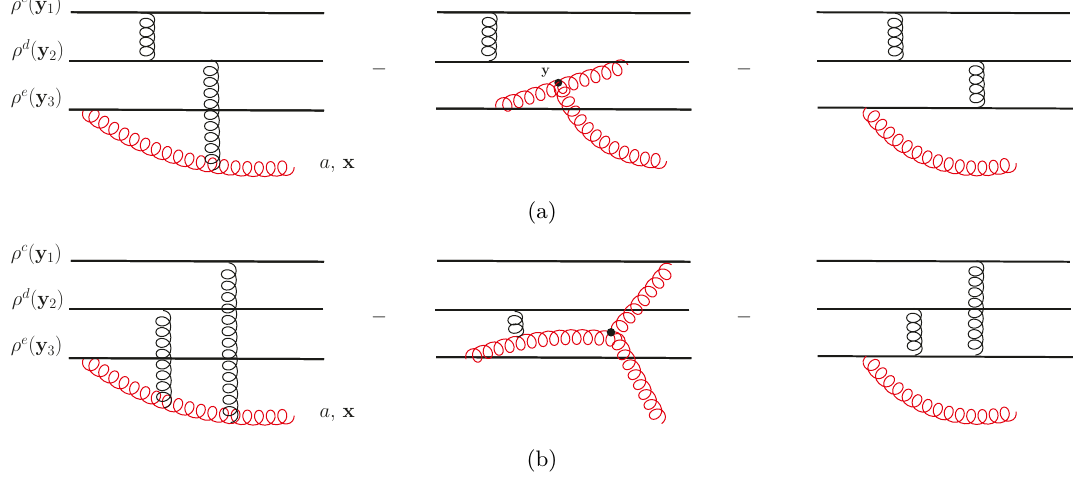
( x ) produced at transverse P , y and y . Similar diagrams with 1 2 3